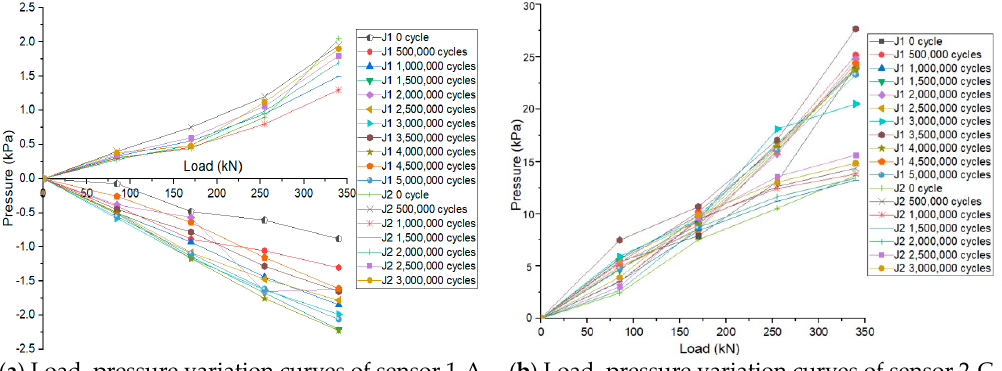
Figure 13. Load–pressure variation curves of measuring sensors ( a ) 1-A and ( b ) 2-C.